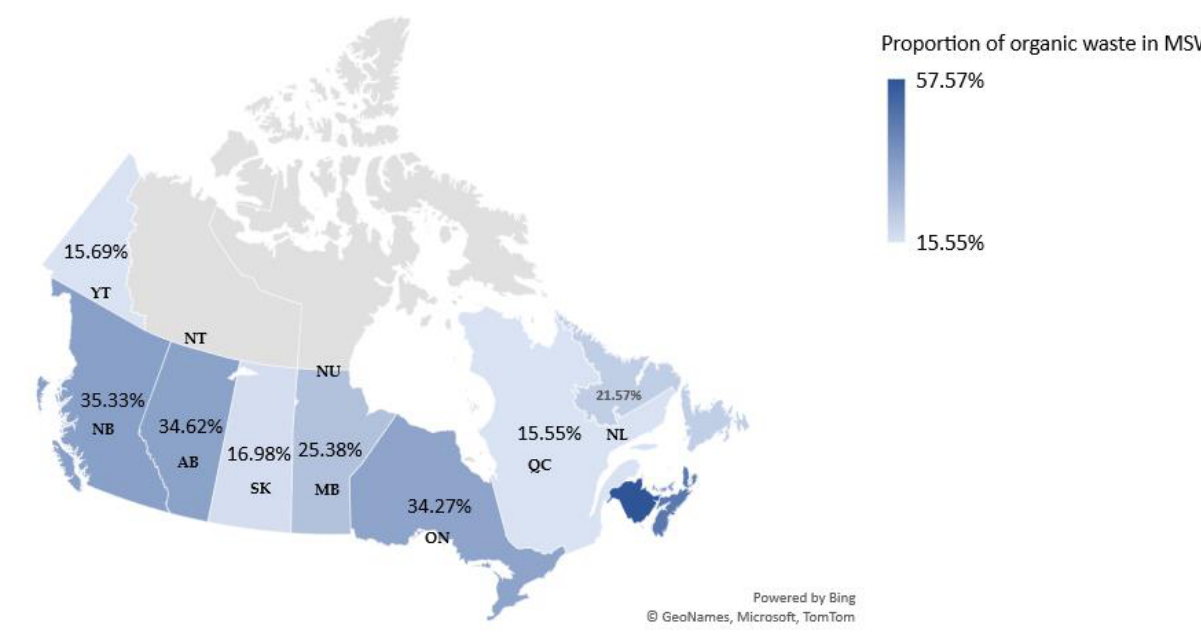
Figure 2. The proportion of organic waste diverted from municipal waste in Canada by province. The authors originally produced the figure from Canada ’ s national statistical agency [9].